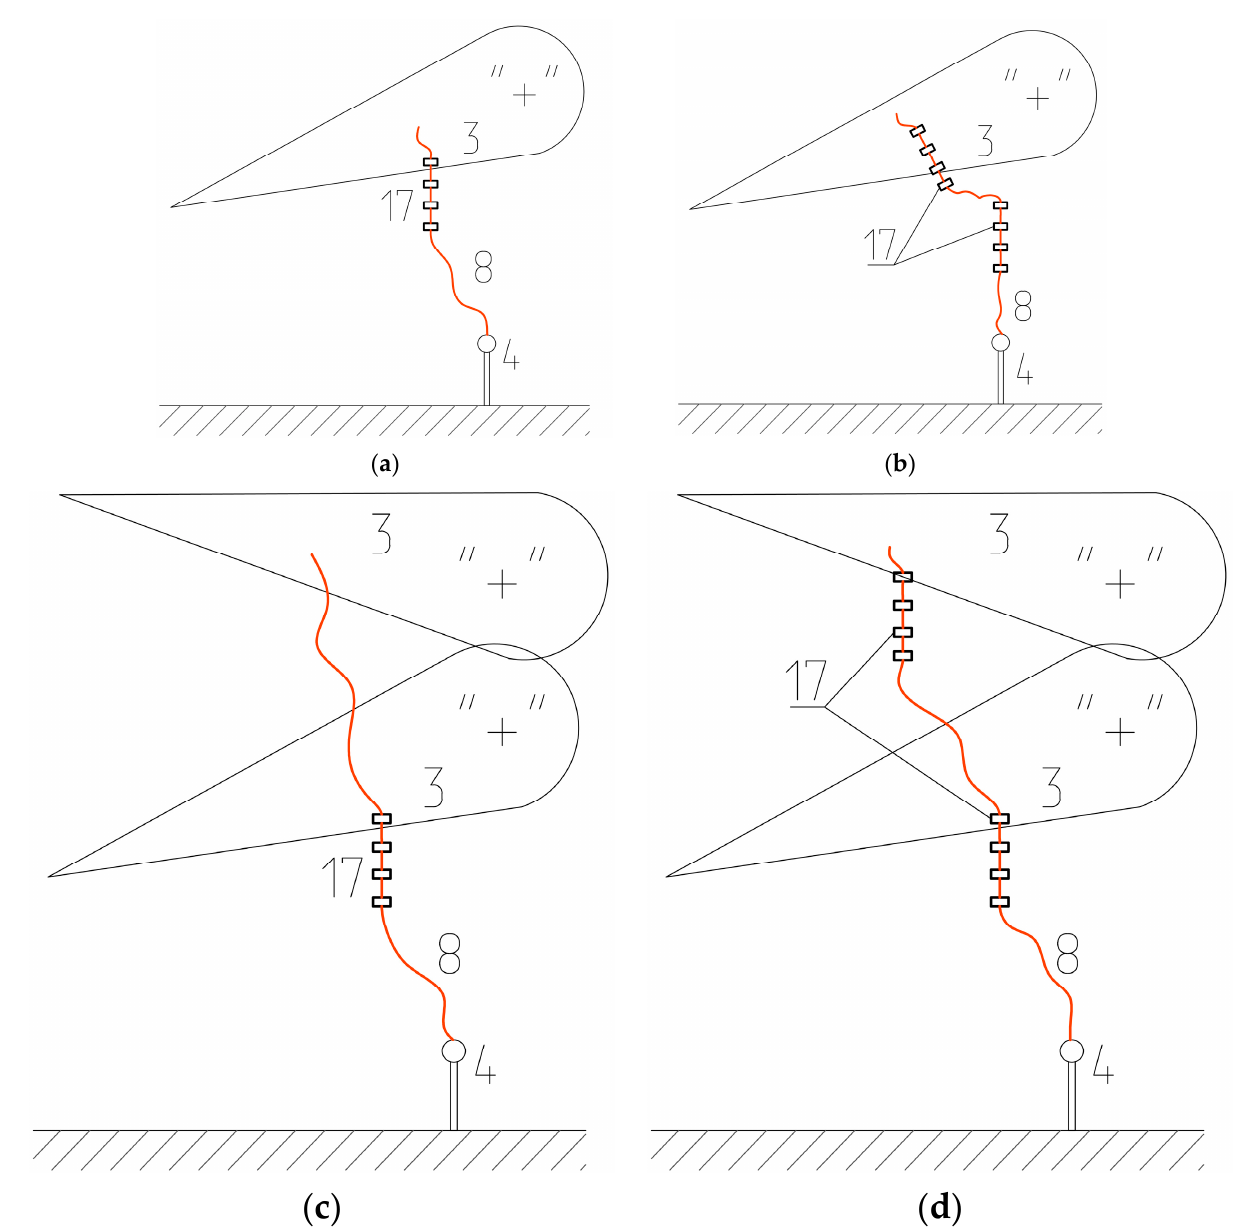
of model hydrometeors was located near the lower boundary of the cell. The fourth series of experiments used two ATCs and two groups of model hydrometeors (Figure 2d). The upper group of model hydrometeors was located in the space between the cells, and the lower group was located near the lower boundary of the lower cell, partially within its boundary layer. The distance between the groups was ~40–50 cm.